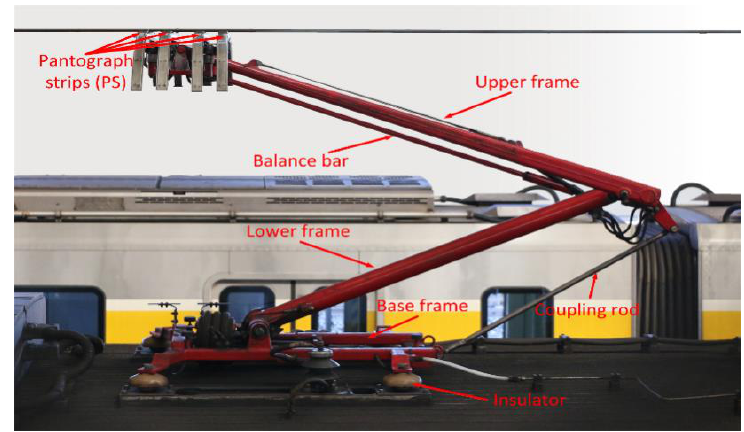
Figure 1. The pantograph of the metro vehicle.